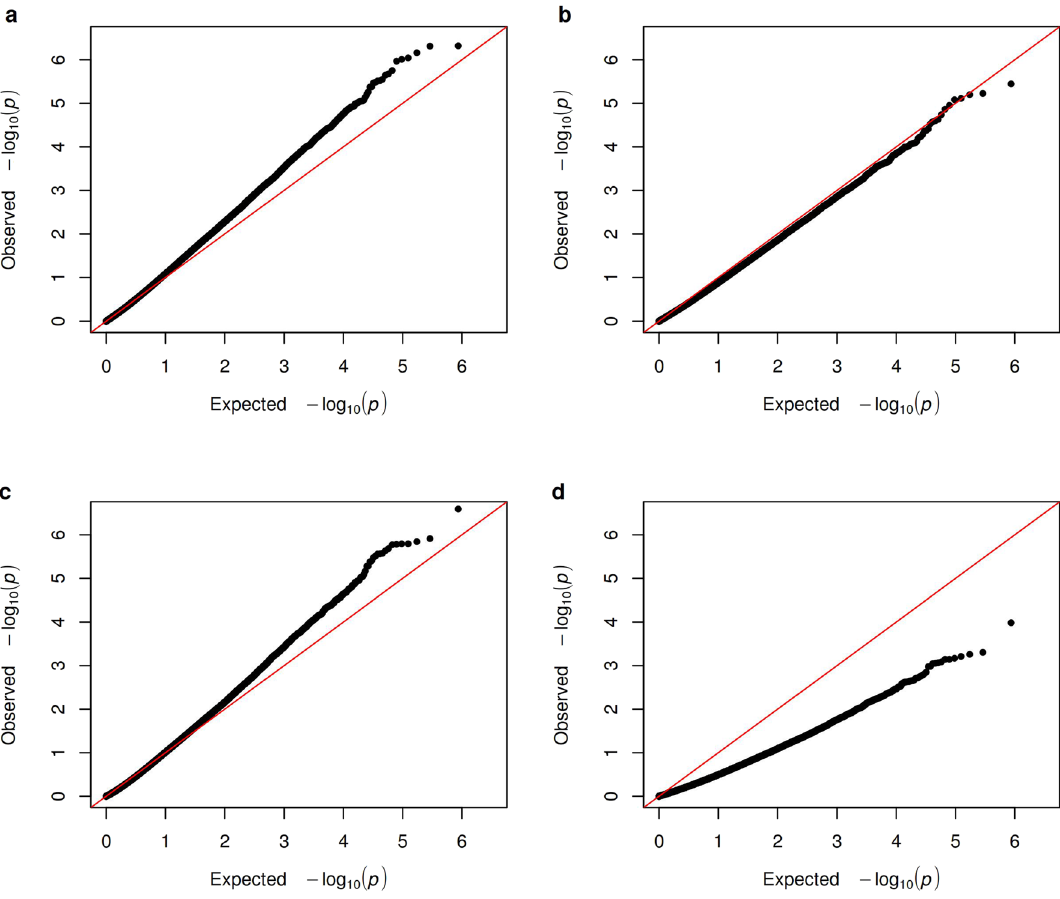
Figure 1. Quantile–quantile plots for ( a ) SWD group, ( b ) control group, ( c ) either group, and ( d ) both groups. Dots represents individual CpG sites and the line